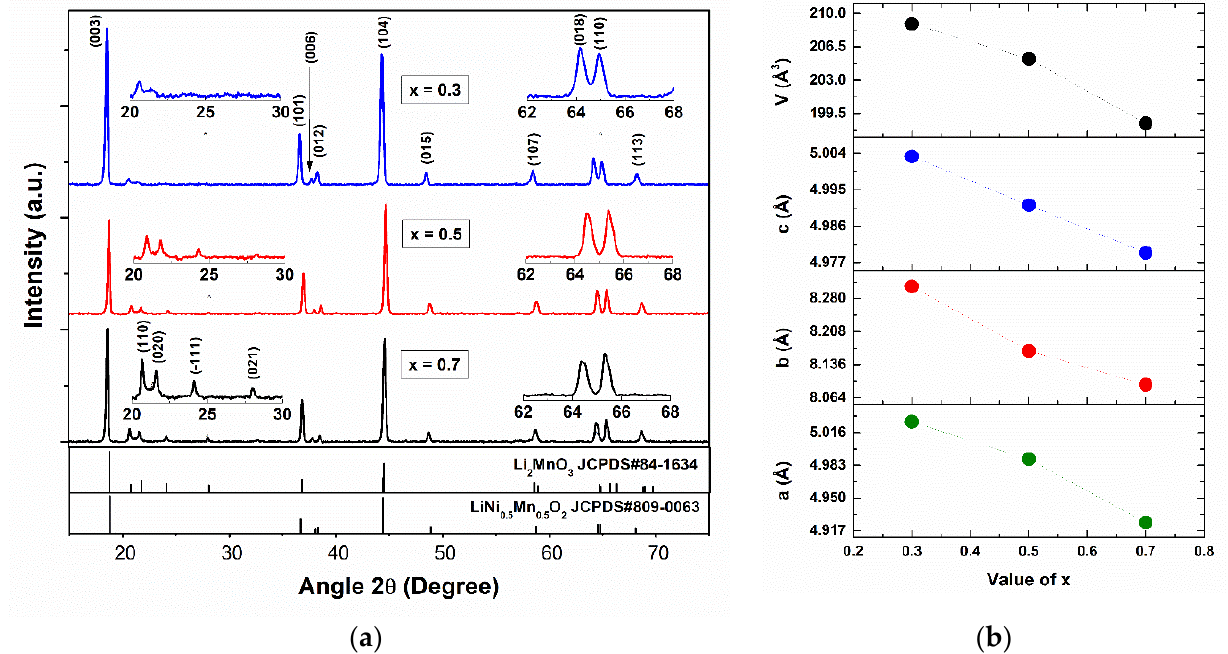
Figure 1. ( a ) X-ray diffraction patterns and ( b ) monoclinic structure lattice parameters of xLi 2 MnO 3 –(1−x)LiNi 0.5 Mn 0.5 O 2 .